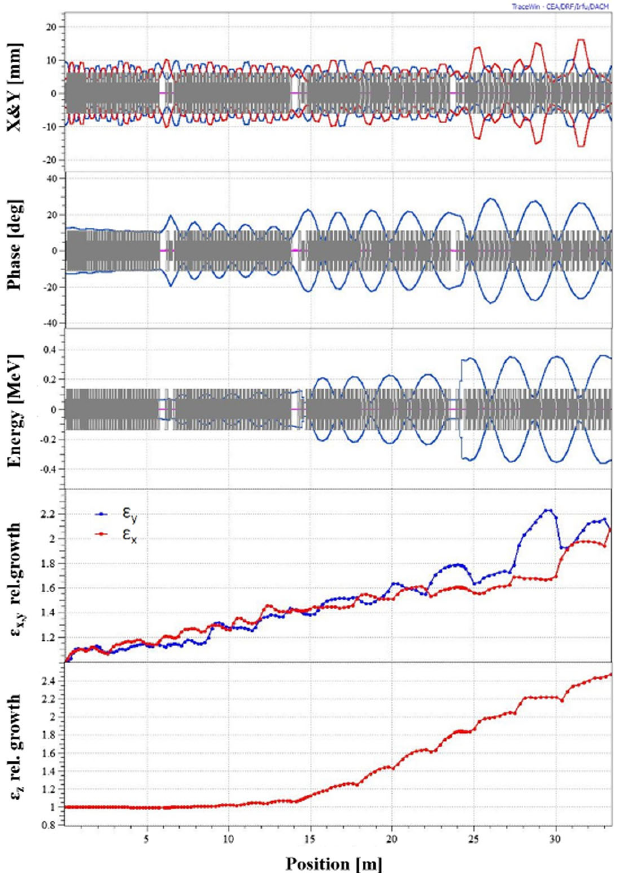
FIG. 10. Beam envelopes, transverse, and longitudinal rms- emittance growth for the prolonged cavity with three intercavity sections, k 0 ;t ¼ 65 °, k 0 ;z ¼ 120 °.